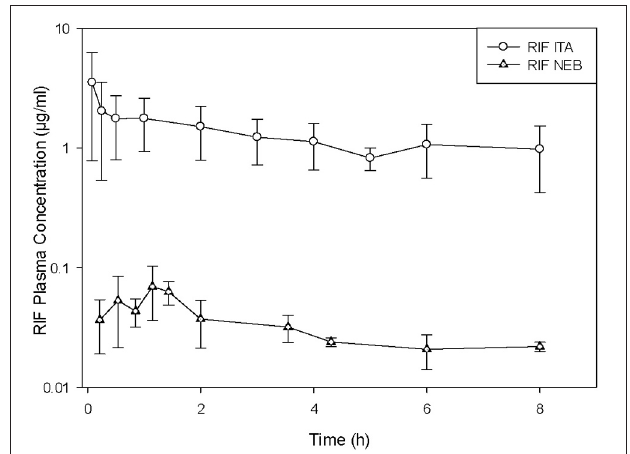
FIGURE 1 | Plasma concentration versus time curves in guinea pigs after administration of rifampicin suspension (RIF) by intratracheal liquid instillation (ITA) and nebulization (NEB). (Average ± standard deviation, n = 3–5). Modified from García-Contreras and Hickey (2002).